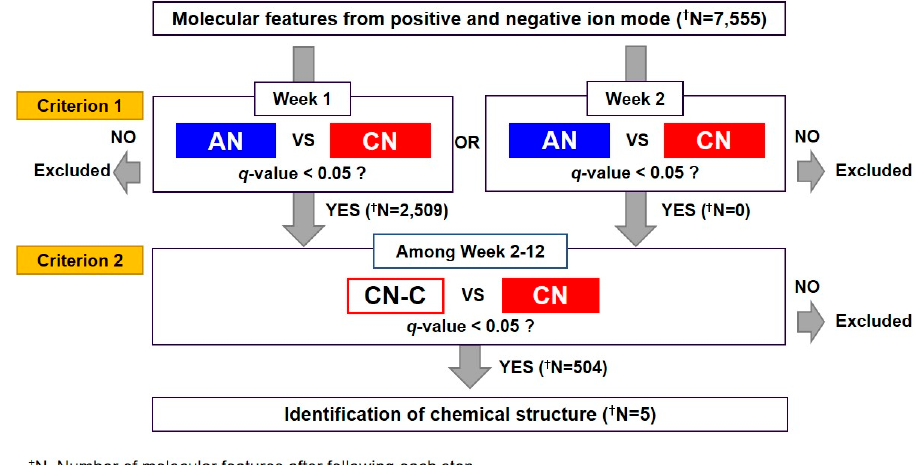
Figure 5. Scheme of the untargeted metabolomics strategy to determine urinary biomarkers predictive of the progression of nephritis. The predictive criterion were as follows: ( 1 ) q -value < 0.05 when the CN group was compared to the AN animal at Week 1 or 2, representing early-stage nephritis, even if there was no significant di ff erence in proteinuria between the AN and CN groups; and ( 2 ) q